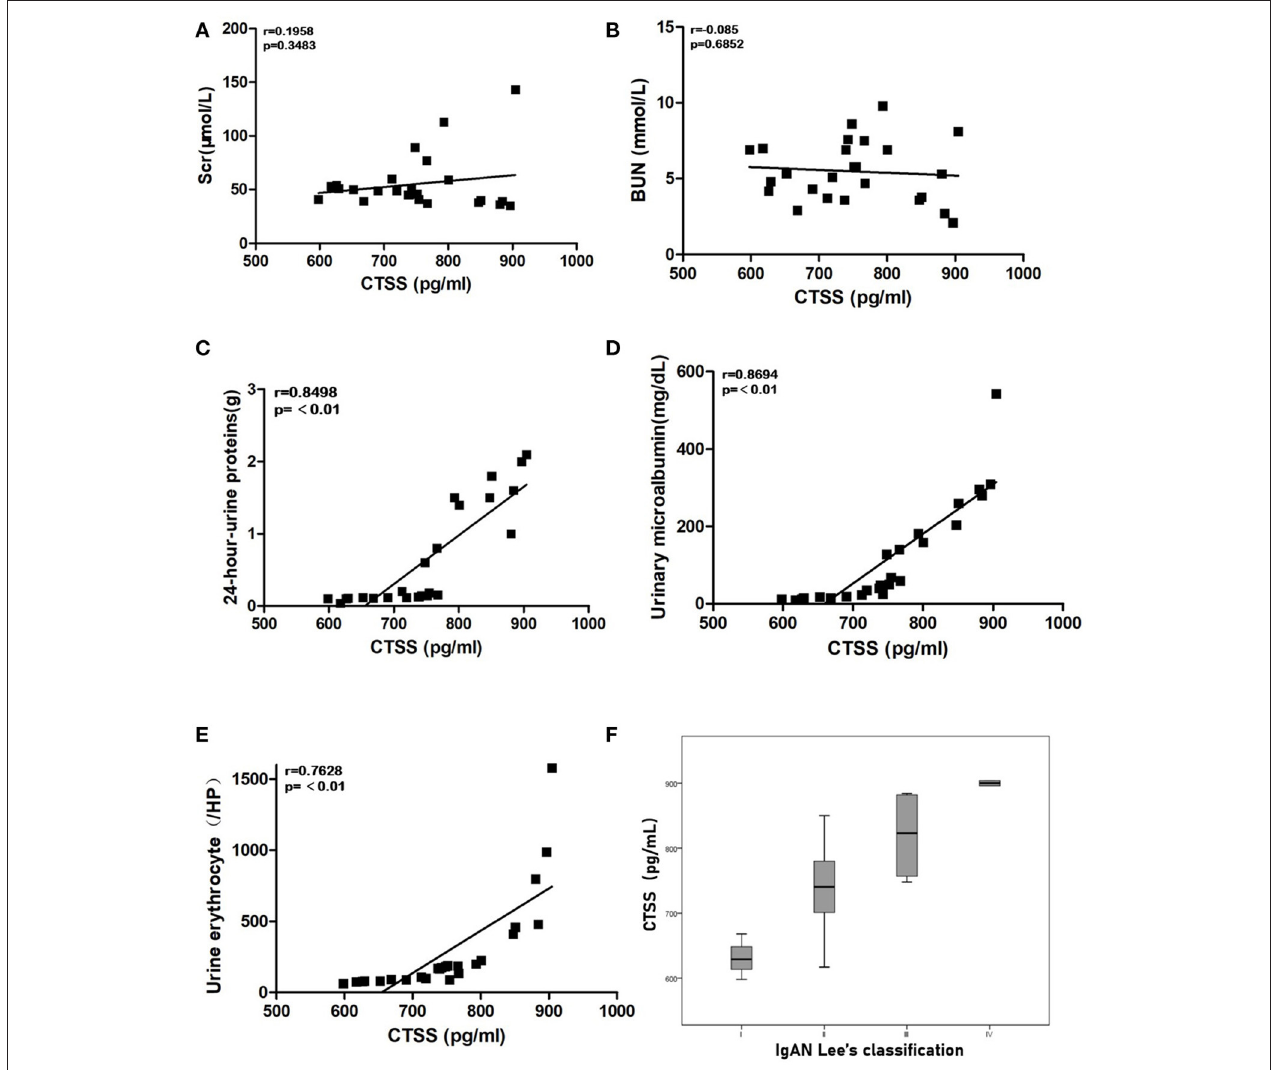
FIGURE 2 | The levels of serum CTSS are correlated with clinical measures in IgAN patients. The potential correlation between the levels of serum CTSS and the values of each clinical measure were analyzed by Pearson-correlation coefficient ( r ). Data are the mean values from individual patients. (A) The levels of serum Scr. (B) The levels of serum BUN. (C) The levels of 24-h-urine proteins. (D) The levels of urinary microalbumin. (E) The numbers of urine erythrocytes in each high power field. (F) Stratification analysis of CTSS levels in different groups of IgAN